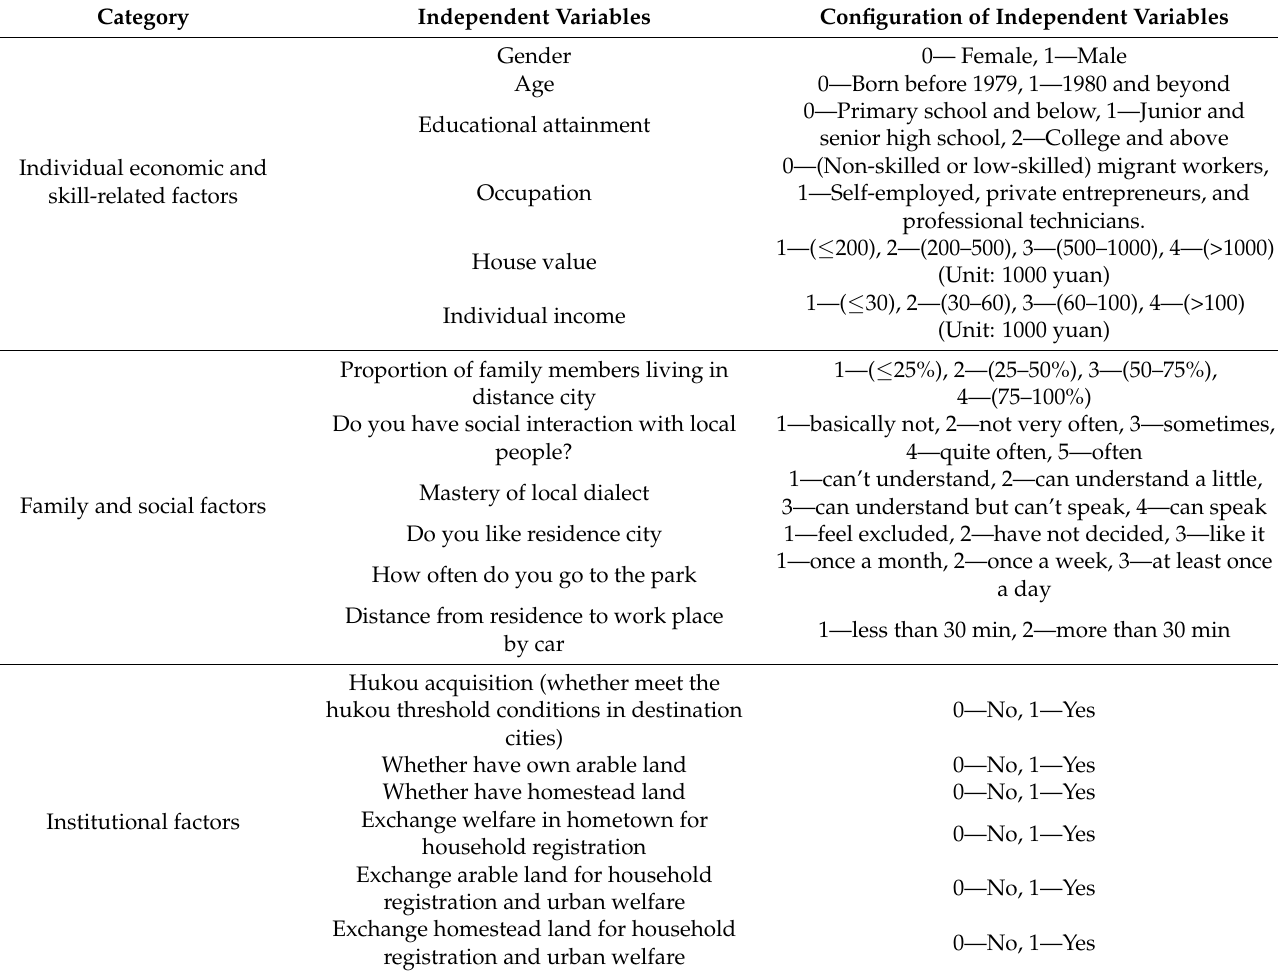
Table 1. Configuration of independent